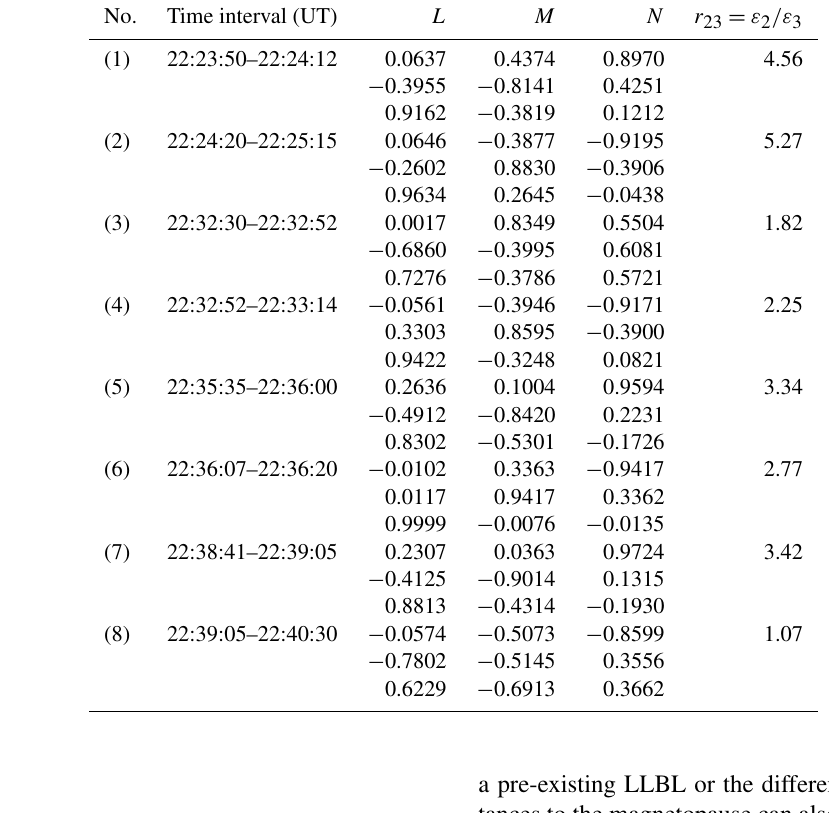
Table 1. Results of MVA analysis at the four magnetosheath encounters of TH-A. The ratio of the second to third eigenvalues r 23 = ε 2 /ε 3 is shown in the right column.